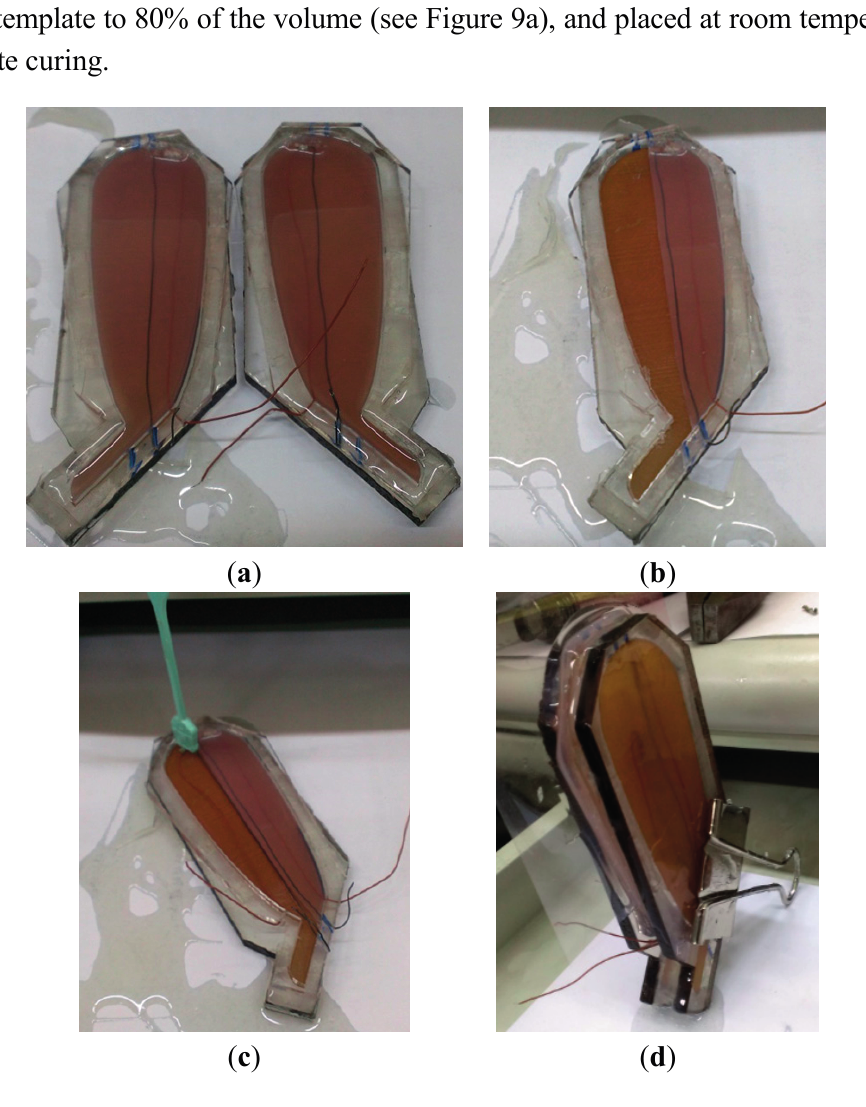
Figure 9. Leaf production processes: ( a ) PDMS infusion mode of 80% volume being filled for hardening; ( b ) remove other side of PDMS at the center; ( c ) implant SMA in the position of removal; ( d ) symmetric binding after the second